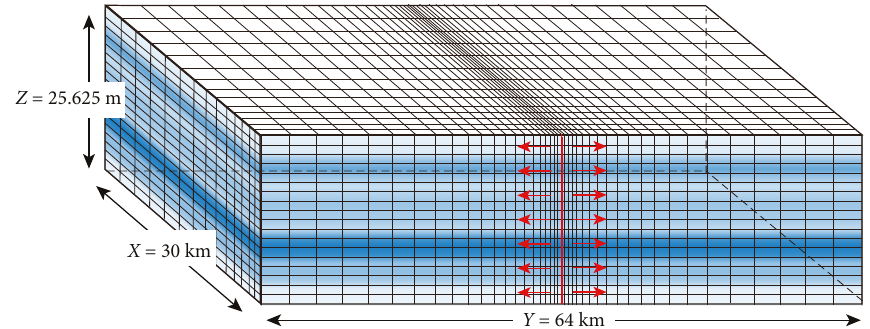
Figure 16: 3D model of one injection